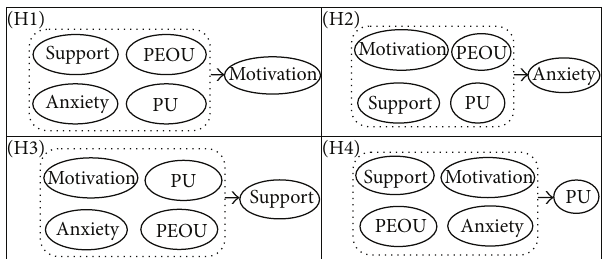
Figure 3: Theoretical relationships between different constructs impacting LMS